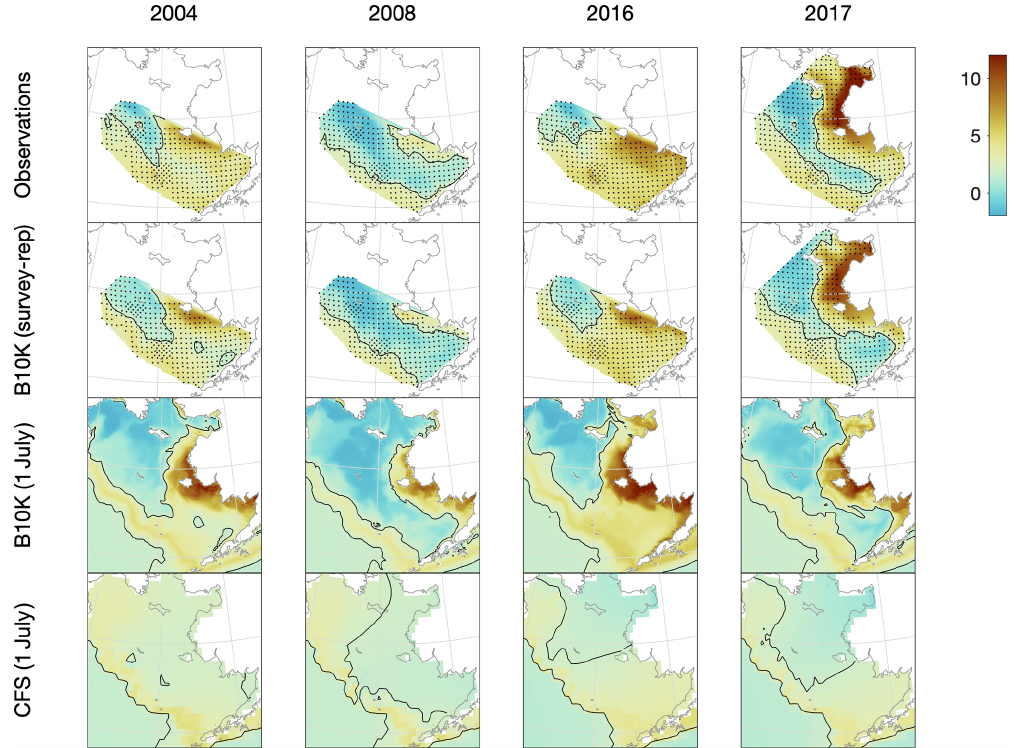
Figure 4. Comparison of observed, Bering10K-simulated, and CFS-simulated bottom temperature on the eastern shelf under a variety of conditions, including 2004 (a warm year), 2008 (a cold year), 2016 (an atypical warm year, where anomalously warm water from the Gulf of Alaska pushed the cold pool further northwest than usual), and 2017 (one of the few survey years when samples were collected from the northern Bering Sea). Discrete samples from the groundfish survey and the survey-replicated model datasets (indicated by black dots) were interpolated to the model grid using natural neighbor interpolation; the black contour line indicates the 2 ◦ C edge of the cold pool. Table 1. Correlation, bias, root mean squared difference (RMSD), and model efficiency for each model estimate of mean bottom temperature or cold pool index compared to the observed temperature/index. Statistics are applied to annual time series. Metric Model Correlation Bias RMSD Efficiency Mean bottom temperature B10K (survey rep)